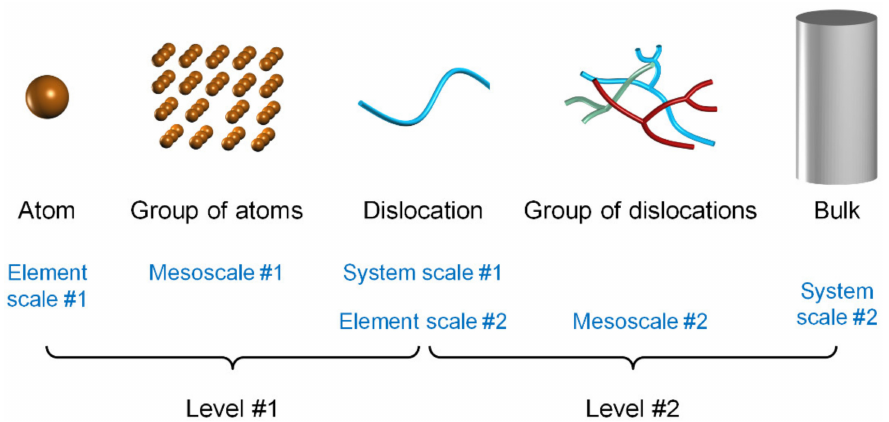
Figure 1. Two typical levels of mesoscale complexity in metals